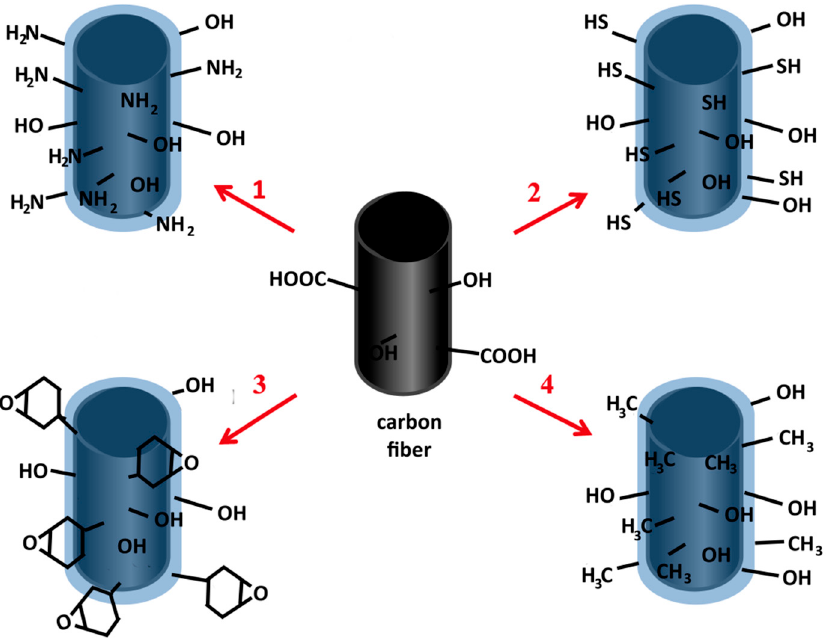
Figure 1. Scheme of carbon fiber surface functionalization by the sol-gel coatings (with numbers compatible with numbers of coatings described in manuscript).